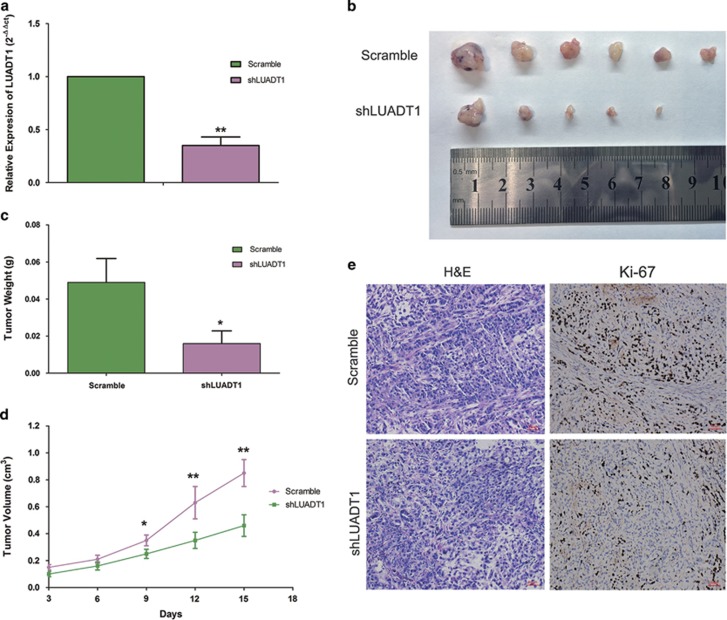
The silencing of LUADT1 inhibited LUAD growth in vivo. LUADT1-targeting or scrambled shRNA was transfected into A549 cells, and then, the cells were injected into nude mice. (a) LUADT1 expression was downregulated in the shLUADT1-transfected cell-derived xenograft tumors. The xenograft tumor weight (c) and volume (b and d) in the shLUADT1 group were significantly lower than those in the scrambled shRNA group. IHC staining was performed on xenograft tumors, and the Ki67 staining signal was weaker in the shLUADT1 group than in the scrambled shRNA group (e). *P<0.05, **P<0.01. Error bars indicate means±S.E.M.